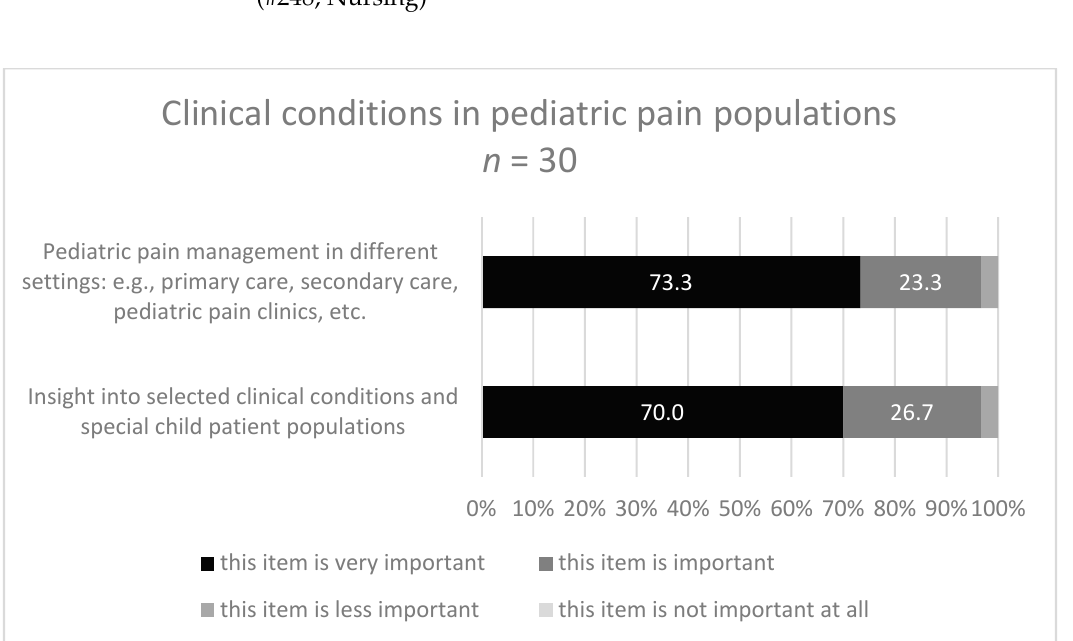
Figure 6. Response categories with highest/lowest accordance in area 4 (Clinical conditions). Table 3 . Comparison of experts’ ratings and guidelines.